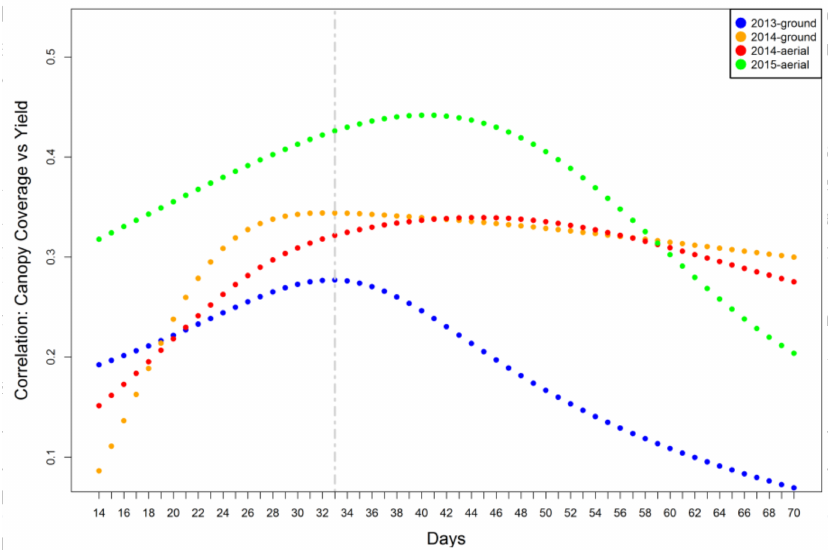
Figure 1. Correlation between the interpolated daily canopy coverage values and yield for data sets including 2013-ground, 2014-ground, 2014-aerial, and 2015-aerial canopy coverage